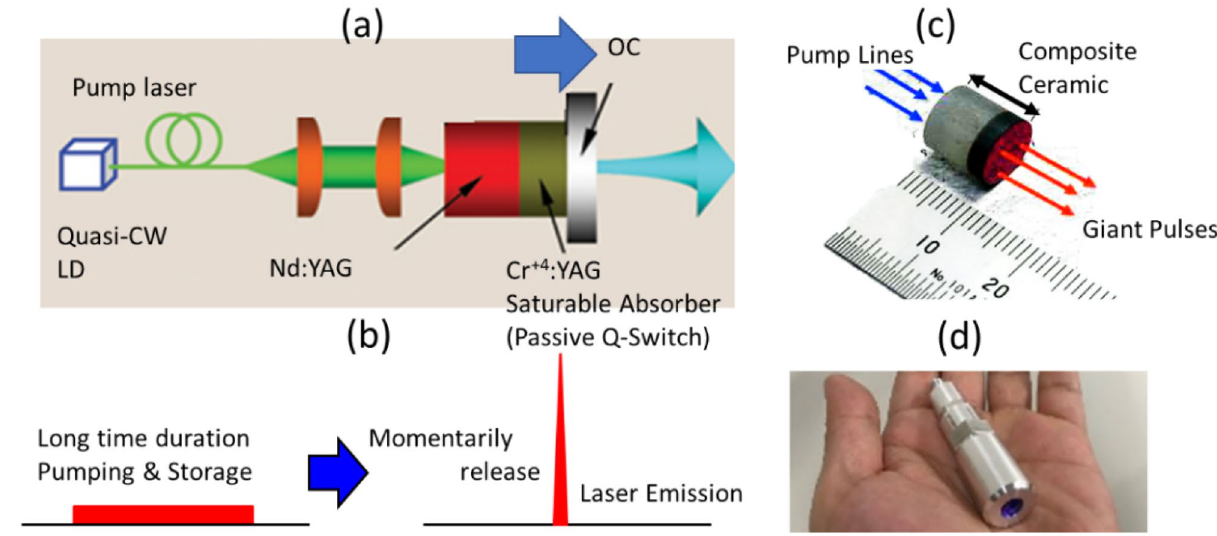
Figure 1. Micro-laser. ( a ) Illustration and ( b ) operating schematic of the monolithic Nd:YAG/Cr:YAG composite ceramic quasi-continuous wave (CW) laser diode (LD) micro-laser, along with actual images of the ( c ) ceramic composite and ( d ) stainless steel